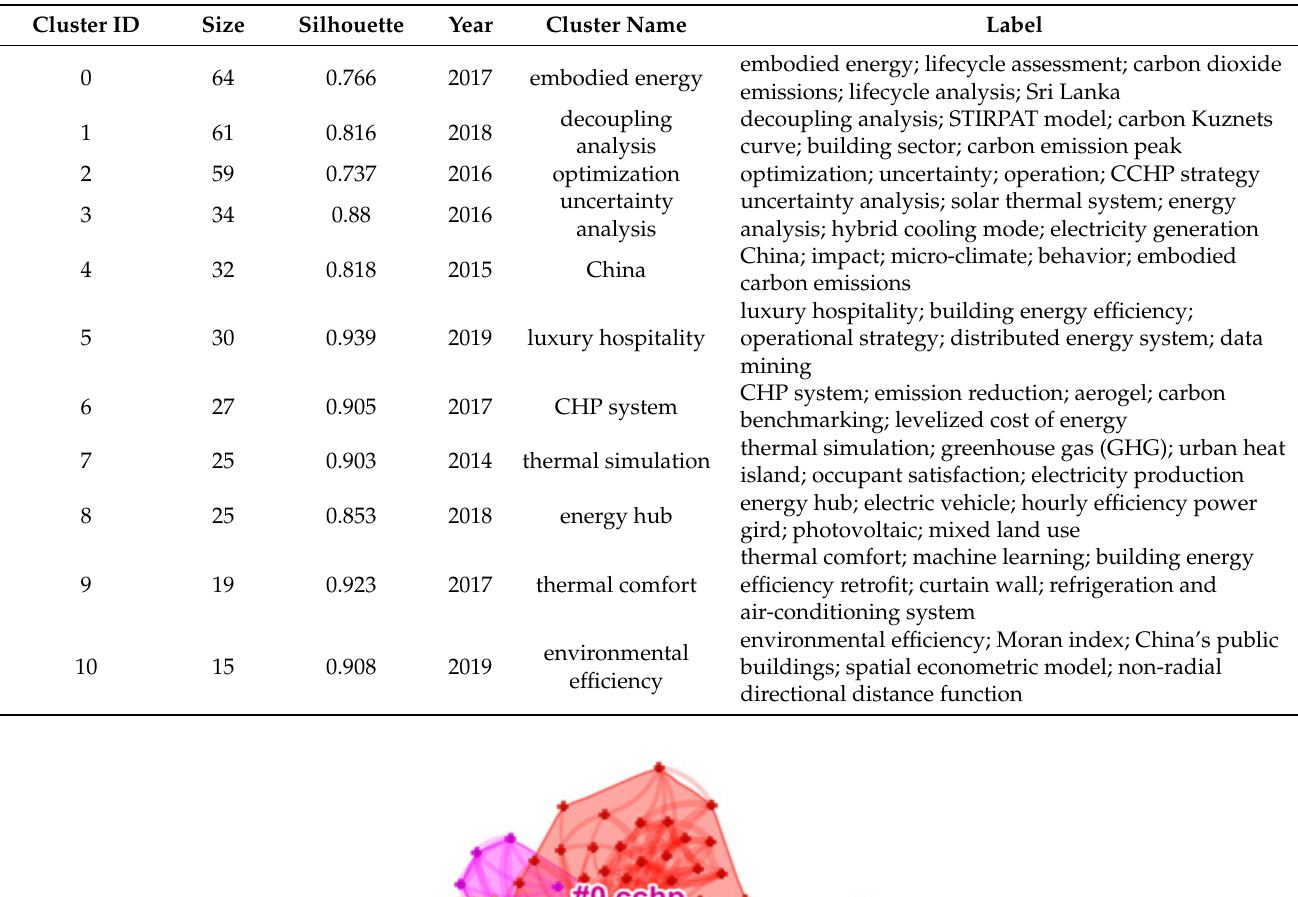
Table 4. Cluster by keywords in the study of carbon emissions of public buildings.